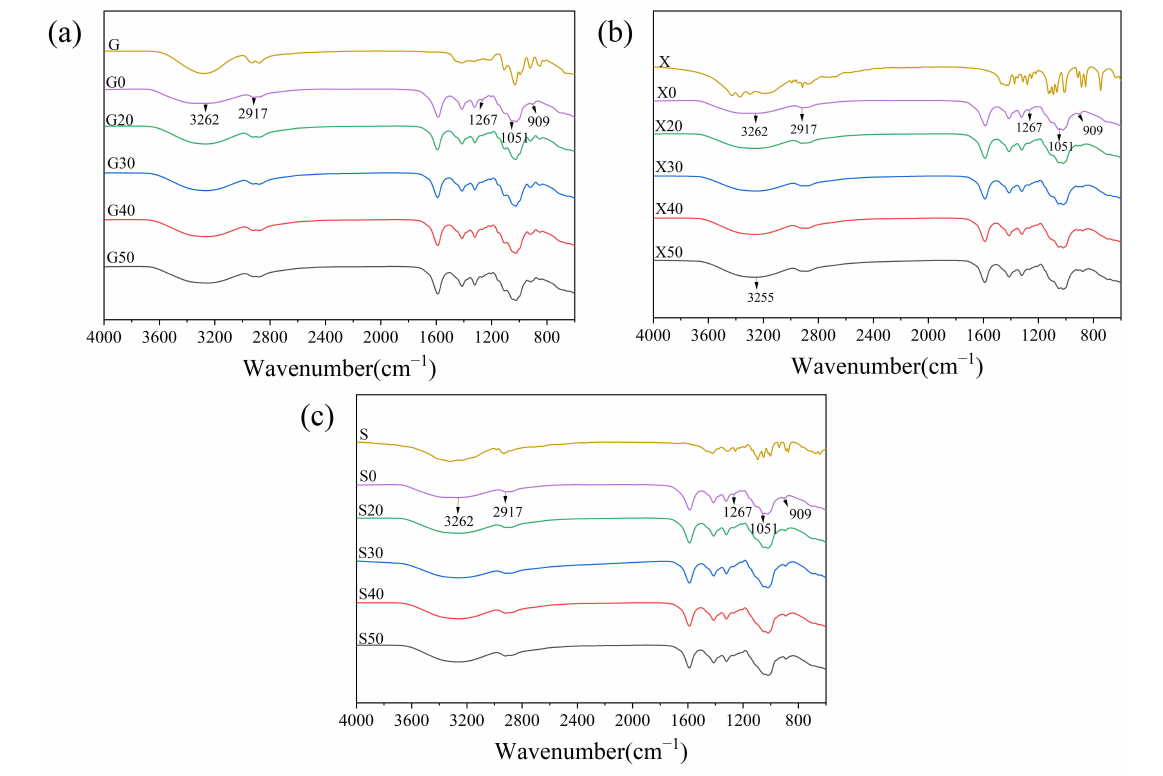
Figure 2. Spectra of the funoran films with different additions of G ( a ), X ( b ), and S ( c